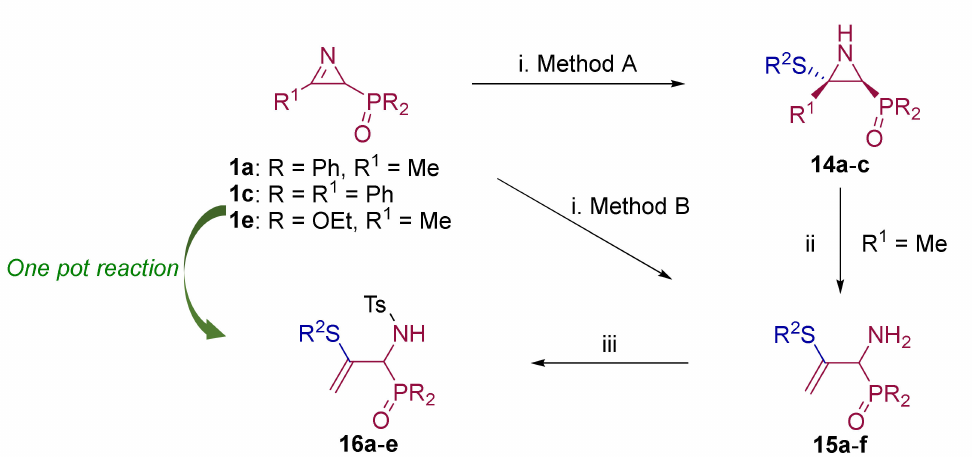
Scheme 4. Synthesis of azidines 14 and allylic α -aminophosphine oxides and phosphonates 15 and 16